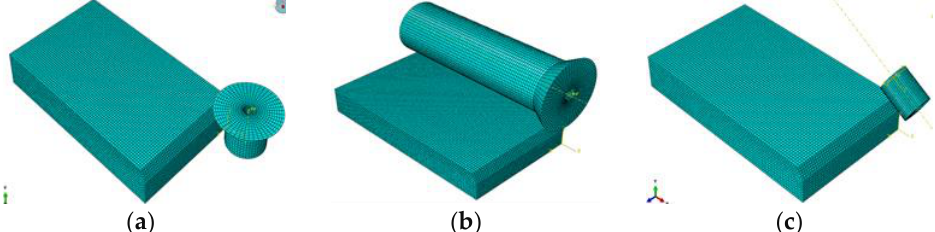
Figure 7. The model of different rolling methods. ( a ) Horizontal rolling; ( b ) vertical rolling; ( c ) frontal rolling using a two-roller.